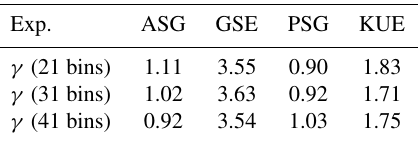
Table 1. Index γ measuring the alignment of the normalized sym- metry function for the four experiments and different resolutions of the pdfs (number of bins). Exp. ASG GSE PSG KUE γ (21 bins) 1.11 3.55 0.90